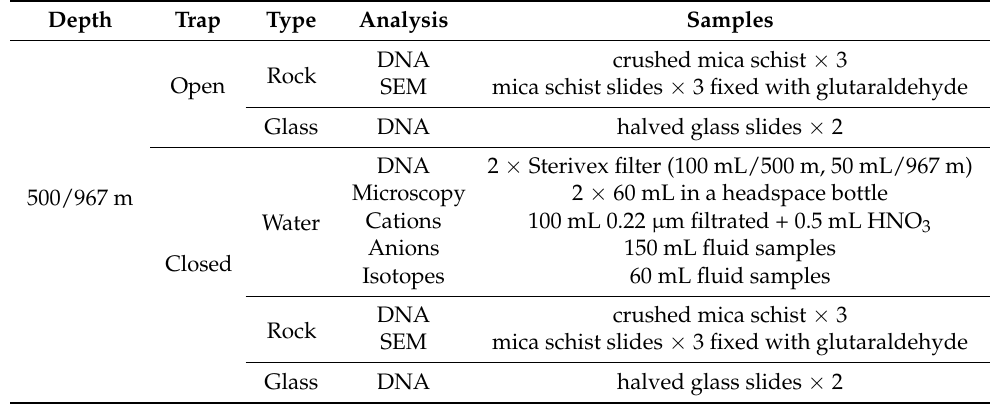
Table 1. Sample types collected from incubated biofilm trap or the connected tube above. A similar set of samples was collected from the trap from each sampling depth (500 or 967